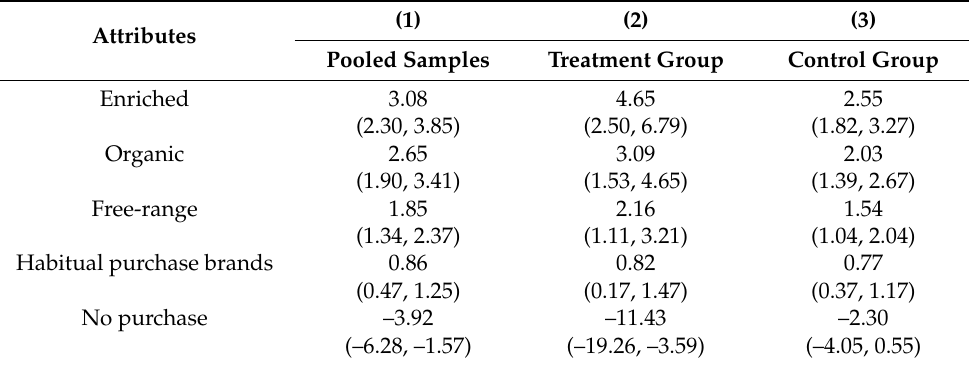
Table 5. Estimated willingness-to-pay (CNY per egg) for different